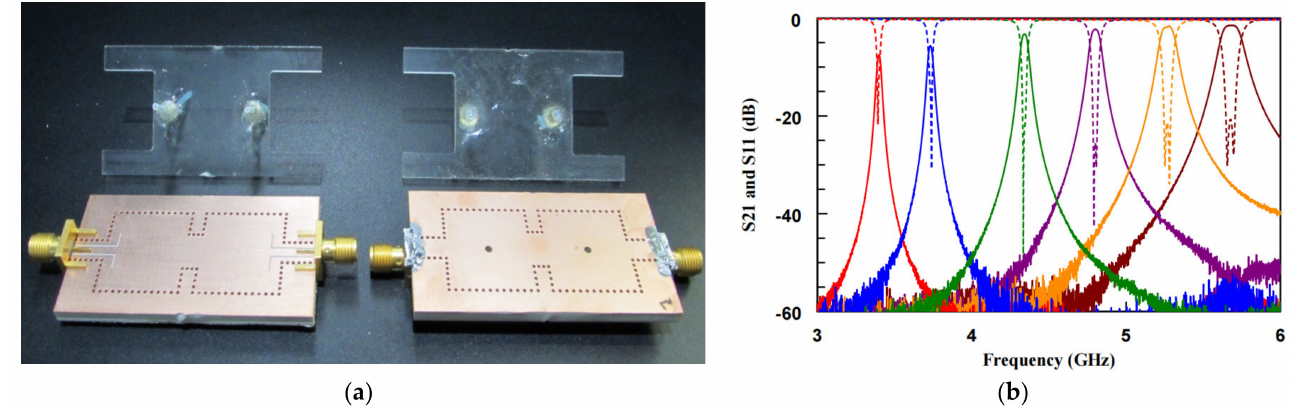
Figure 13. ( a ) Top (left) and bottom (right) views of the LM-based second-order bandpass filters. ( b ) Measured S-parameters of the proposed filter. Reprinted with permission from Ref. [9]. Copyright 2019